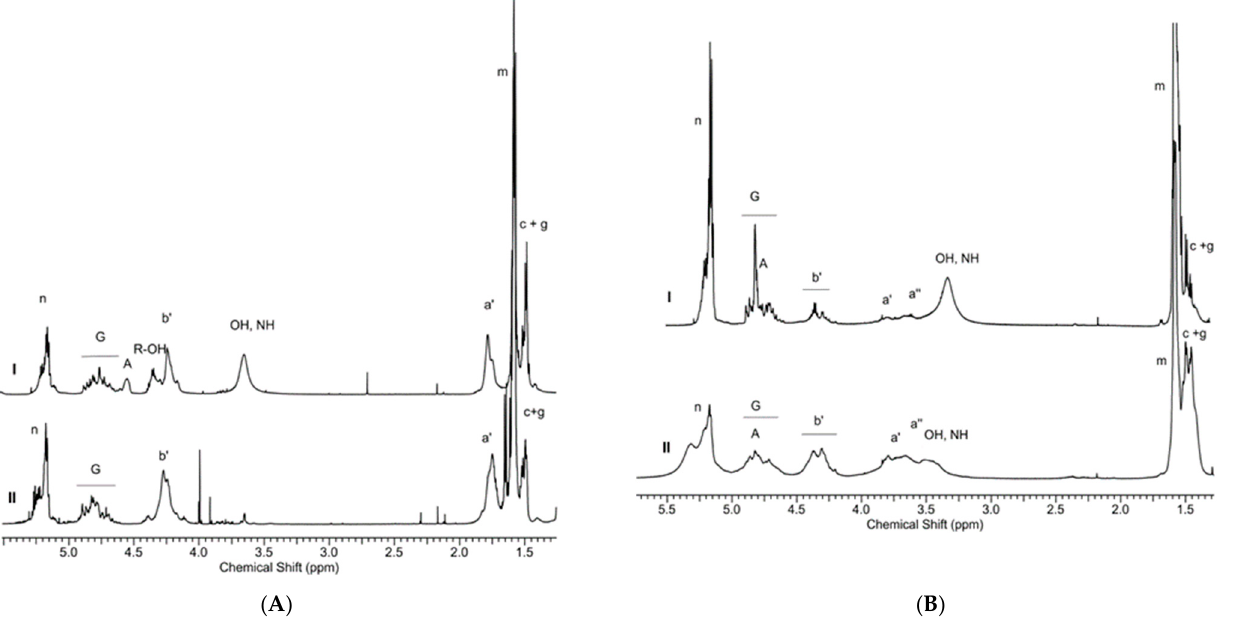
Figure 4. 1 H NMR spectra of the terpolymer obtained during copolymerization of L-lactide and glycolide initiated by: ( A ) poly(tert-butyl-bis(2-hydroxyethyl) carbamate 2,3-O-isopropylidene-l- tartrate)—DIPT + BocDEA, P3 with 18 mol.% ester amine units; ( I )—with unprotected OH and NH groups, ( II )—with unprotected OH and NH groups and after reaction with trichloroacetylisocyanate; ( B ) ( I )—P5, poly{(di-tert-butyl ethane-1,2-diylbis[(2-hydroxyethyl)carbamate] 2,3-O-isopropylidene-l-tartrate)} DIPT + Boc 2 HEDEA with 26 mol.% ester amine units, ( II )—P4 poly{(di-tert-butyl ethane-1,2-diylbis[(2-hydroxyethyl)carbamate] 2,3-O-isopropylidene-l-tartrate)} DIPT + Boc 2 HEDEA with 19 mol.% ester amine units.